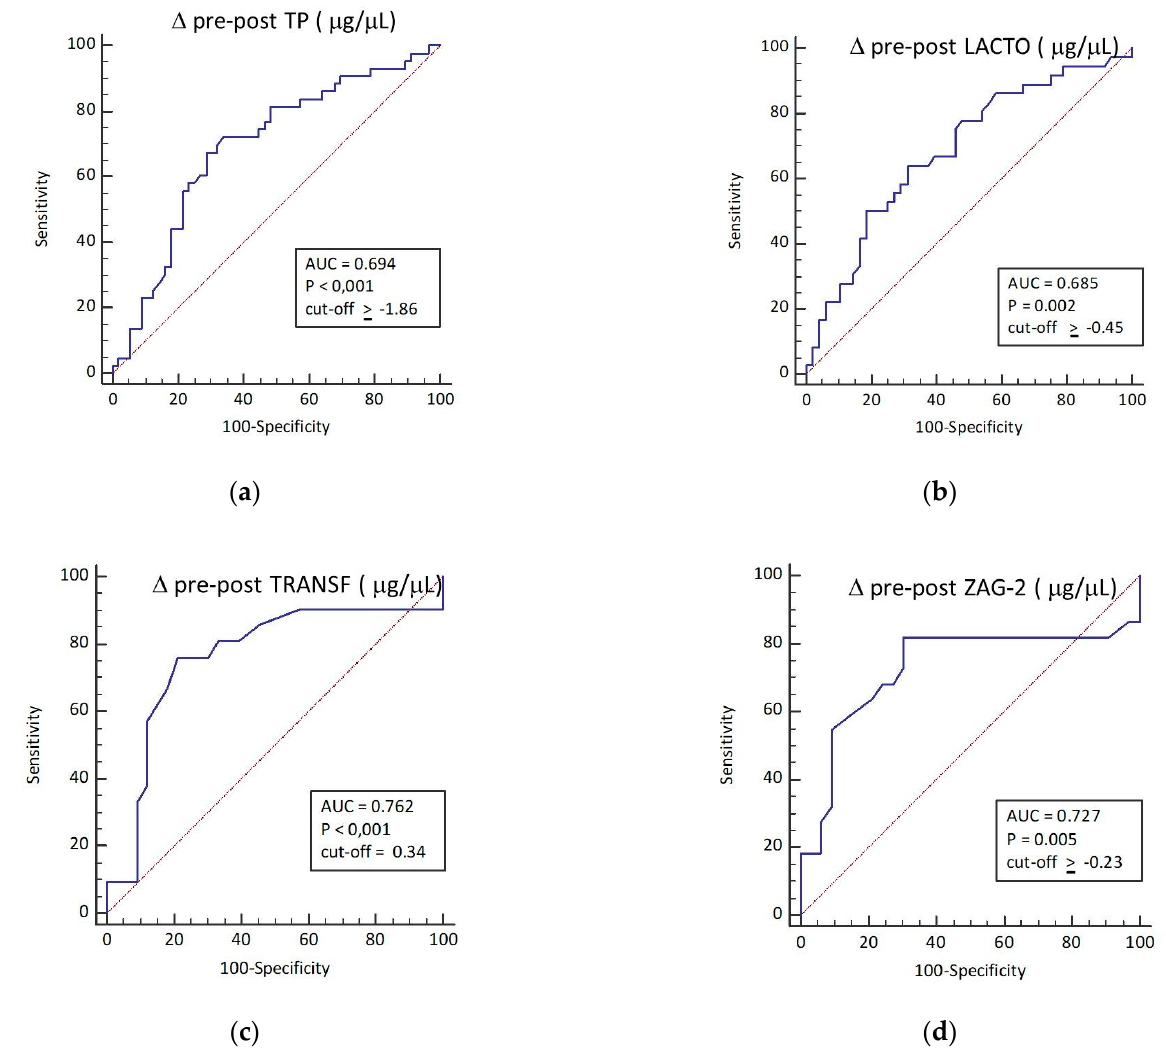
Figure 2. ROC curve analysis performed for ∆ pre-post-TP ( a ), LACTO ( b ), TRANSF ( c ), and ZAG-2 ( d ). The area under the